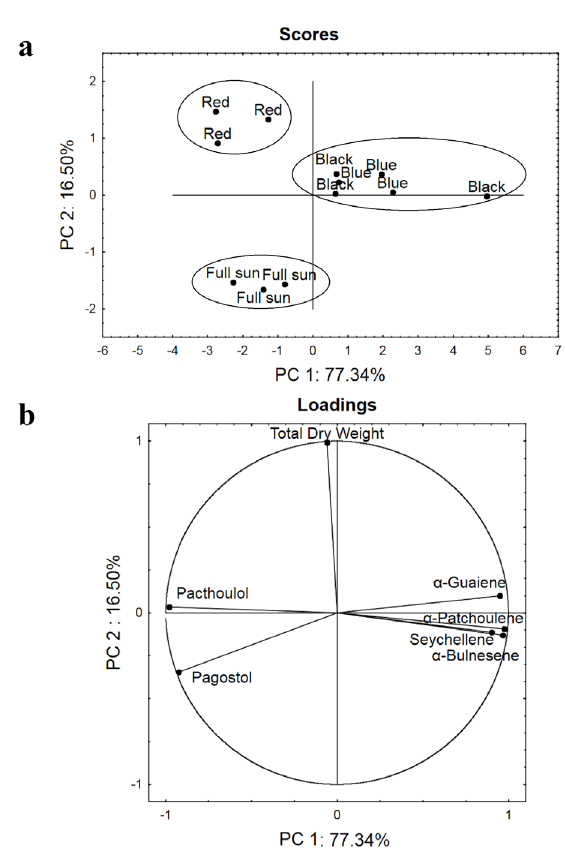
Figure 4 - Scores ( a ) and Loadings ( b ) of the principal components analyses (PCA) on the matrix correlation built using data for six major compound and total dry weight of P.